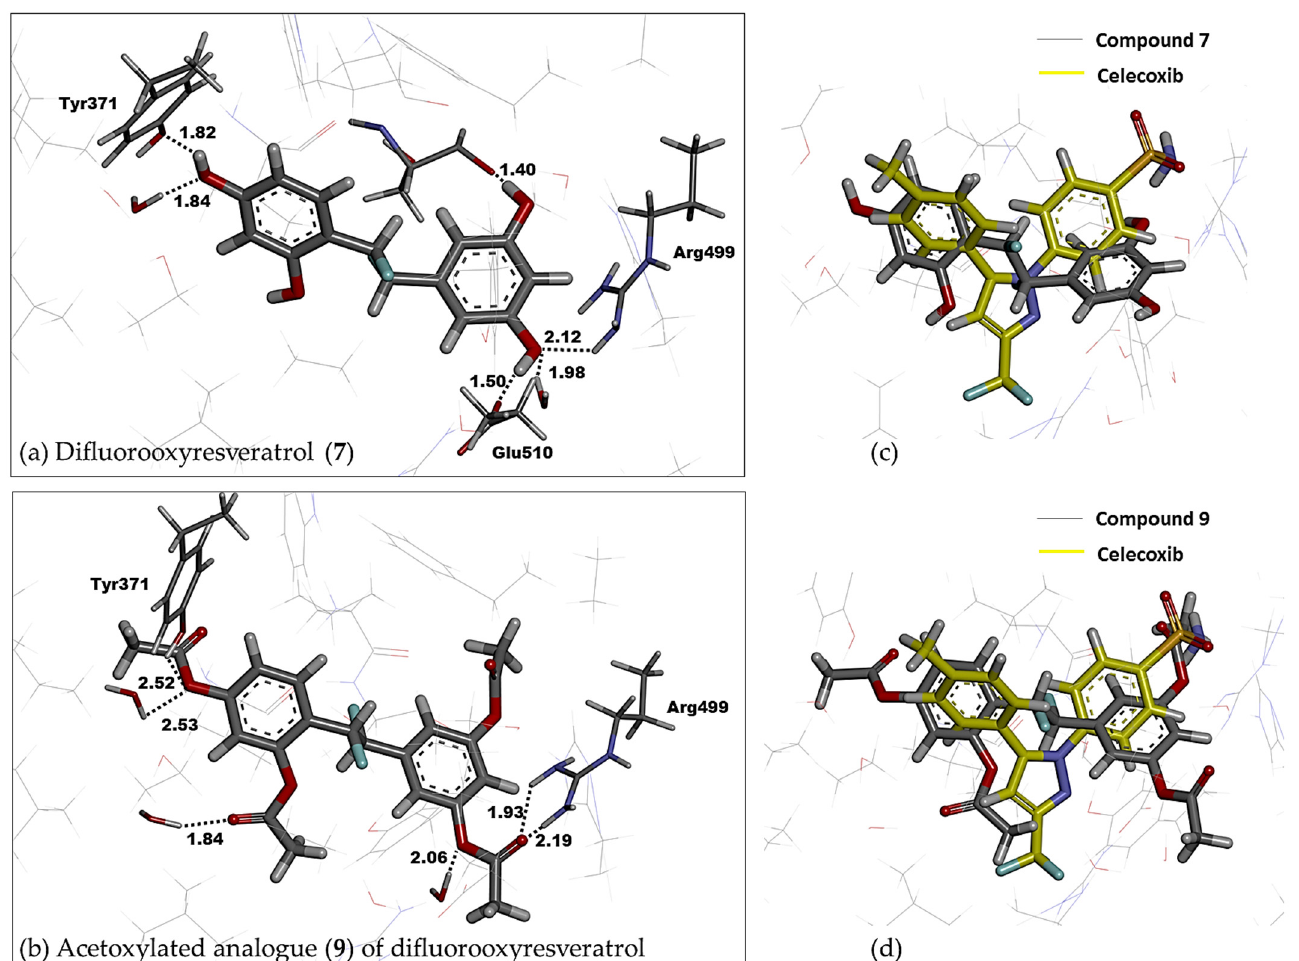
Figure 6. The overlay of the lowest-QM-energy pose of ( a ) difluorooxyresveratrol ( 7 ) and ( b ) acetoxylated analogue ( 9 ) of difluorooxyresveratrol (stick representation in grey) on ( c , d ) a native pose of celecoxib (stick representation in yellow) in the active site of COX-2.